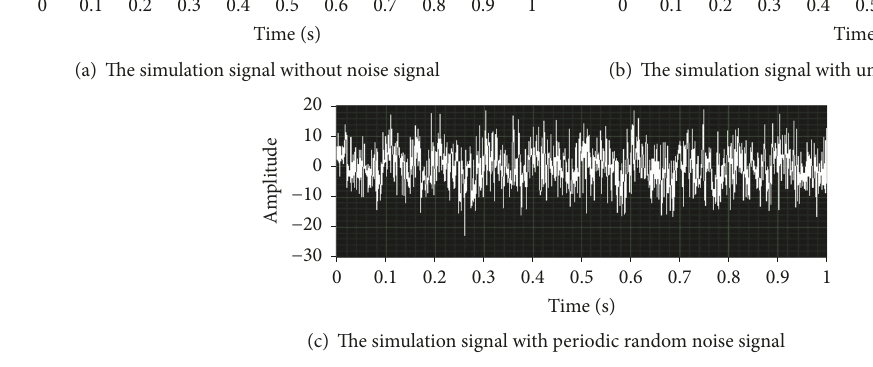
Figure 1: The simulation